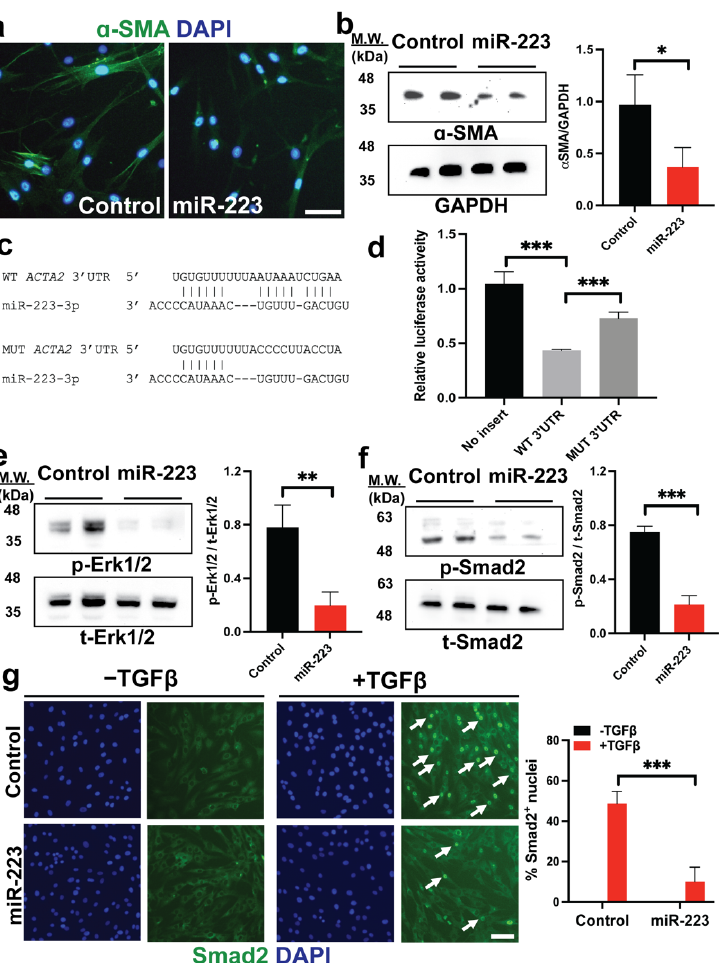
Figure 4. miR-223 directly targets ACTA2 and impairs fibrogenic signal pathways ( a , b ) Expression of alpha-smooth muscle actin ( α -SMA) in control and miR-223 pHSCs by immunofluorescence and Western blot. ( c ) RNA hybridization between miR-223-3p and the wild-type (WT) or mutant (MUT) sequence of 3′ untranslated region ( 3′ UTR) of ACTA2 transcripts. ( d ) Dual luciferase reporter assay determining direct interaction between miR-223 and ACTA2 3′UTRs by levels of luciferase activity. ( e ) Levels of phosphorylated Erk1/2 in control and miR-223 HSCs determined by Western blot in basal medium conditions. ( f ) Levels of phosphorylated Smad2 in control and miR-223 HSCs determined by Western blot after TGF β exposure. ( g ) Immunofluorescence of Smad2 for control and miR-223 HSCs before and after TGF β stimulation. White arrows indicate cells with nuclear translocation of Smad2. Quantification of nuclear Smad2 + cells were counted from 10 random microscope fields for each group. Data presented as the mean ± SD. N = 3–4 replicates from at least two independent experiments. Student’s t -test; * = p < 0.05, ** = p < 0.01 and *** = p < 0.001. Scale bars, 100 µ m. DAPI: 4 (cid:48)